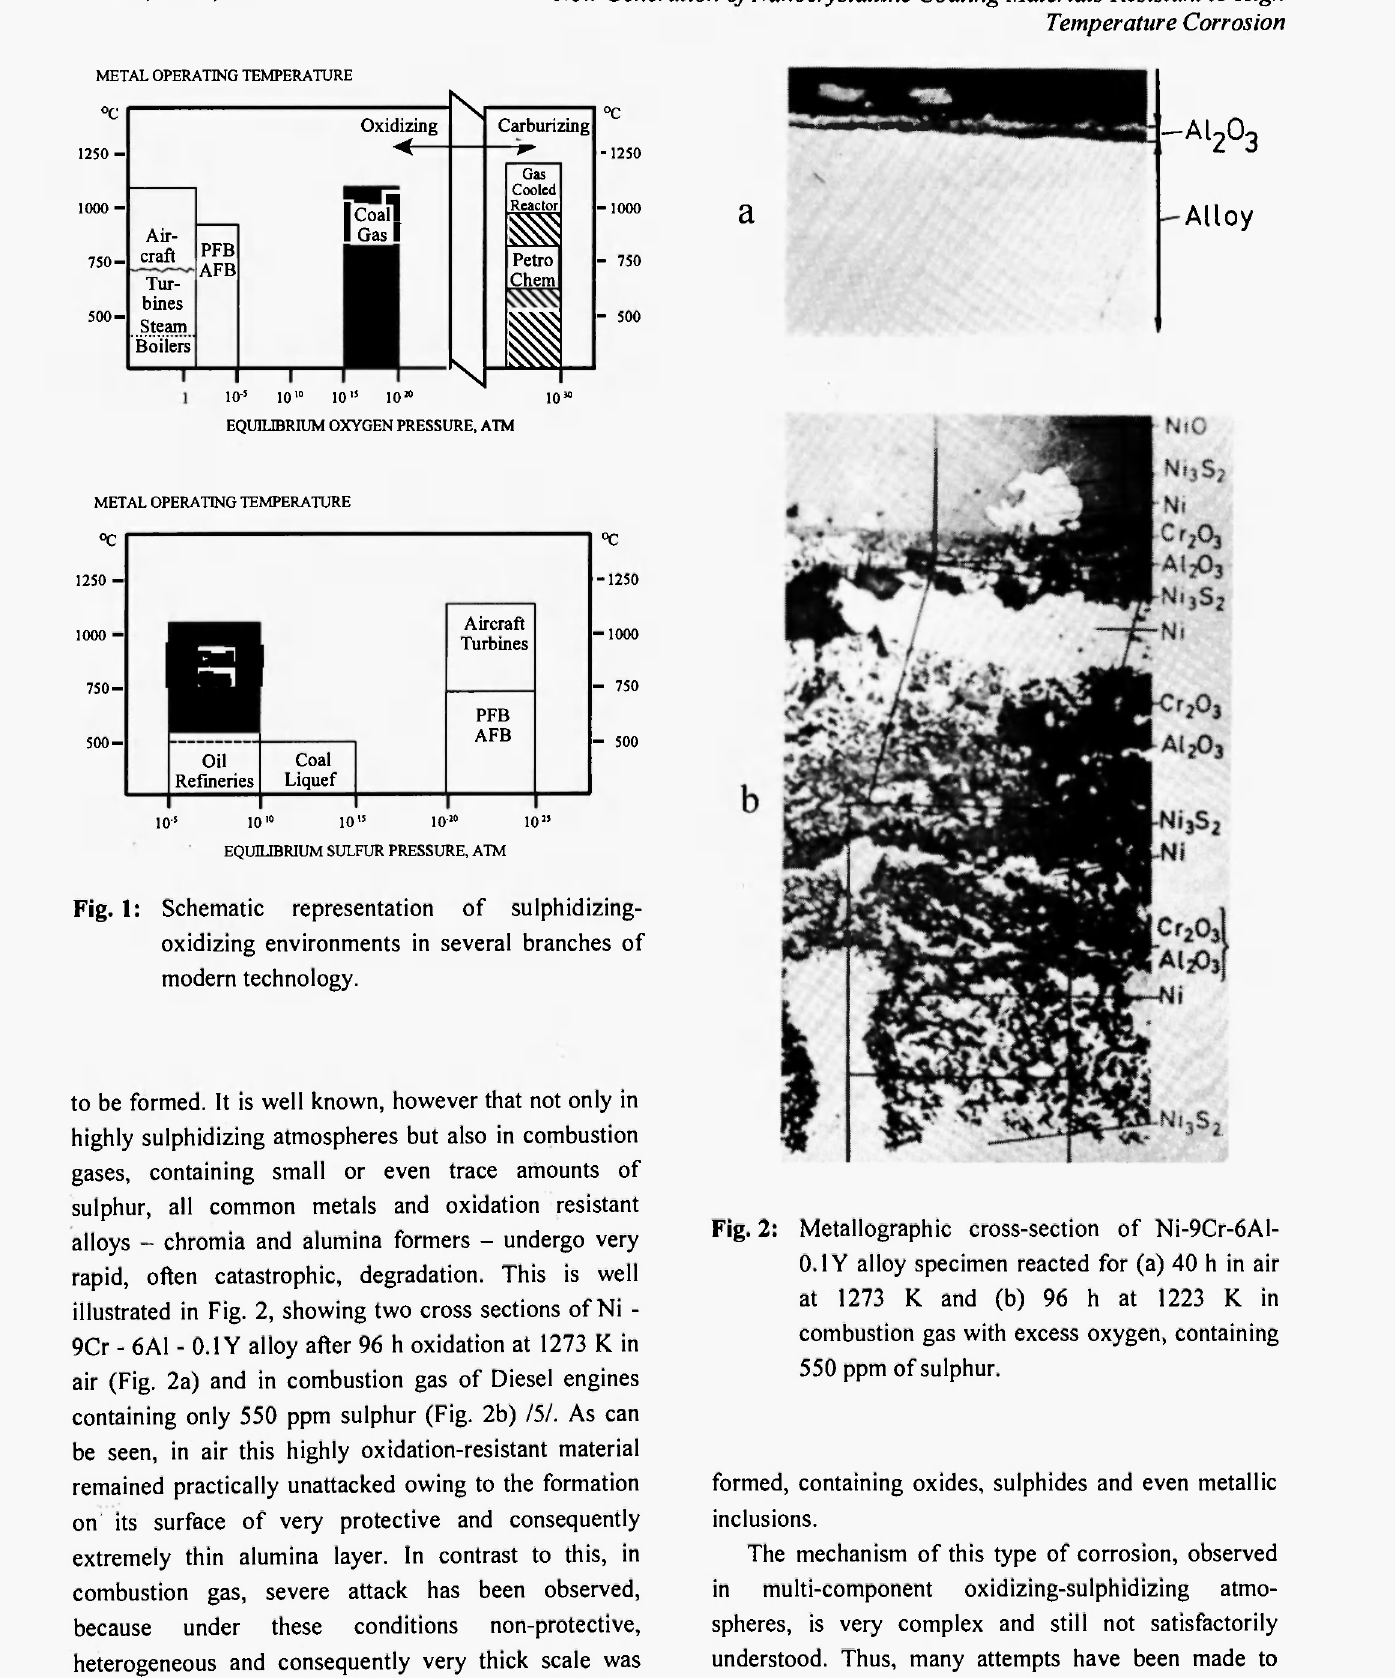
Fig. 2: Metallographic cross-section of Ni-9Cr-6Al- 0.1Y alloy specimen reacted for (a) 40 h in air at 1273 Κ and (b) 96 h at 1223 Κ in combustion gas with excess oxygen, containing 550 ppm of sulphur.